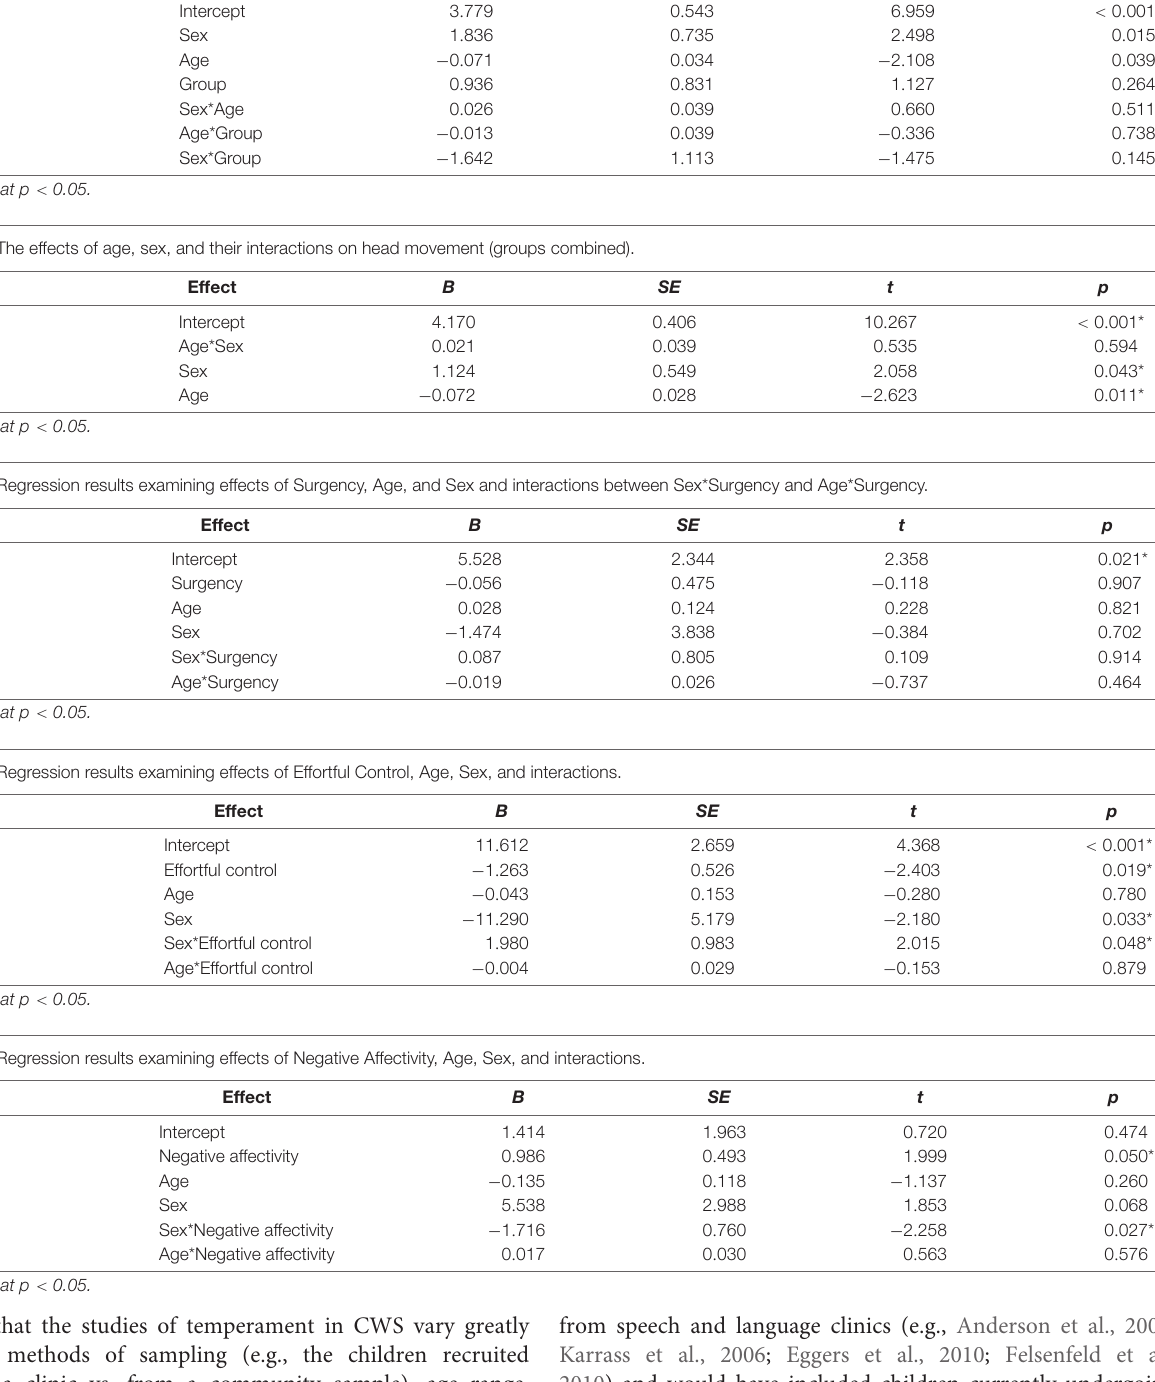
TABLE 2 | The effects of sex, age, clinical status (stuttering, control), and their interactions on head movement. Effect